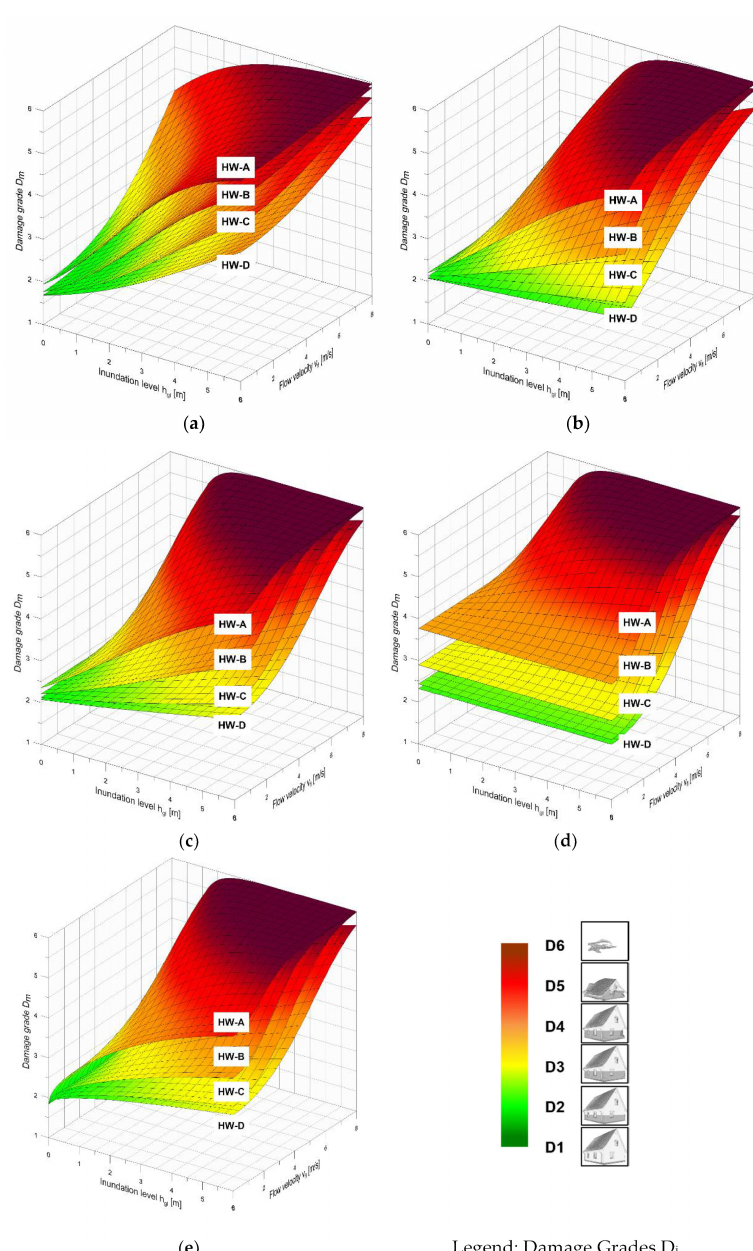
Figure 7. Vulnerability functions for flood vulnerability classes depending on inundation level ( h gl ) and flow velocity ( v fl ): ( a ) variant V1; ( b ) variant V2; ( c ) variant V3; ( d ) variant V4; ( e ) variant V5 (taken from